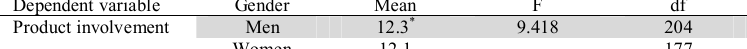
The summary of the results of ANOVA test Dependent